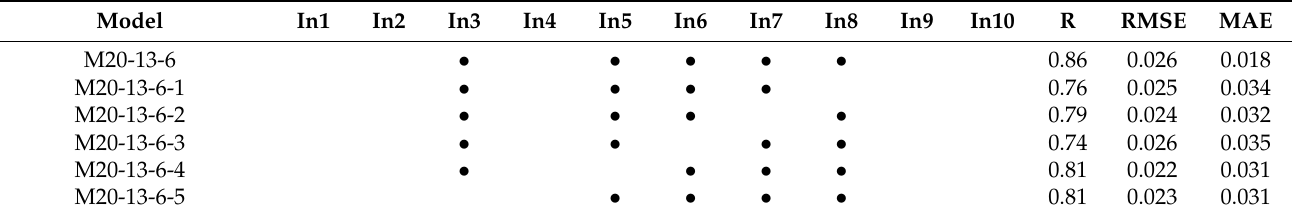
Table 8. Impact of each M20-13-6 bone curvature region variable in medial condyle cartilage volume loss at one year